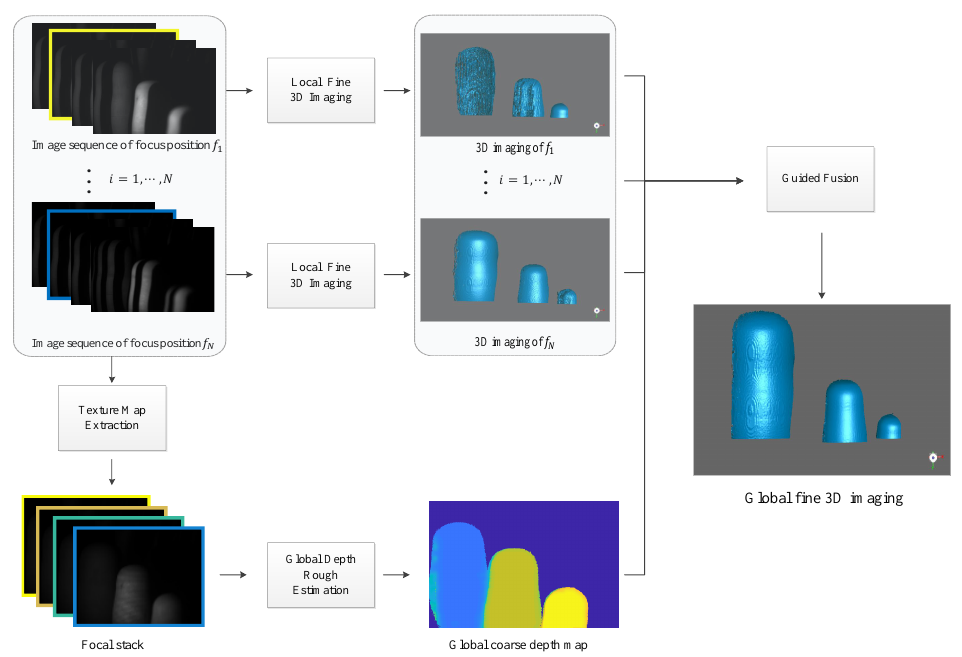
Figure 1. The framework of our proposed method. Image sequences of different focal distances are acquired by the multi-focus illumination-imaging system; then, local, fine 3D measurements and a global coarse depth map are generated by the gray-code method and focus stacking technique, respectively. These local, fine 3D measurements, along with the global coarse depth map, are finally fed into the guided fusion model to get the high-quality 3D measurement of the overall